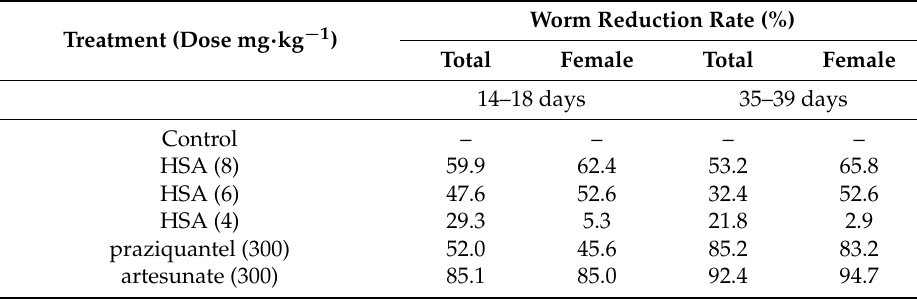
Table 1. Total and female worm burdens in the different dosage of HSA, praziquantel or artesunate treatment against the schistosomula and adult worms of S. japonicum